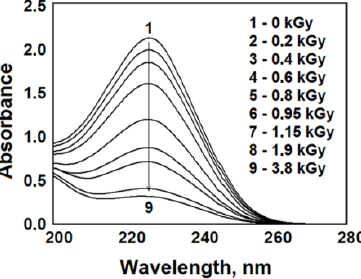
Figure 2. The UV-Vis spectra of irradiated 1 wt.% VT solutions containing Au(III) ions (the ratio (VT)/(Au(III)) is 160/1) and diluted by a factor of 50.